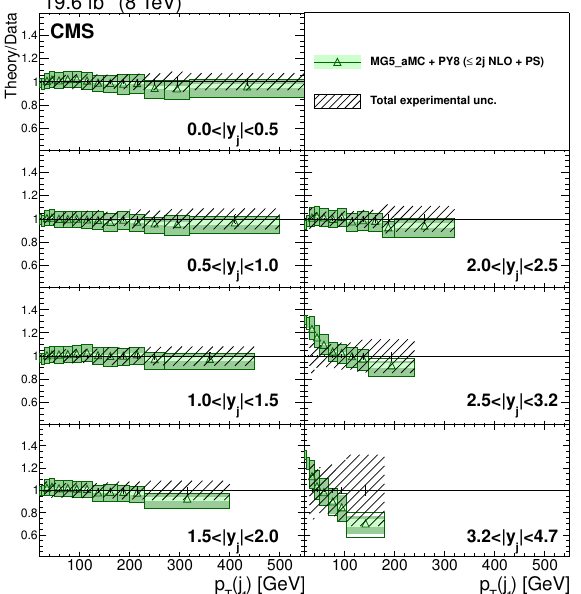
Figure 32 . Ratio to the measurement of the di(cid:11)erential cross section d 2 (cid:27)= d p T (j with mg5 a mc + pythia 8, with up to two jets at NLO. The total experimental uncertainty is shown as a band around 1. Uncertainties in the predictions are shown on the ratio points and include the statistical, theoretical, and PDF uncertainties. The dark green area represents the statistical and theoretical uncertainties only, while the light green area represents the statistical uncertainty alone.